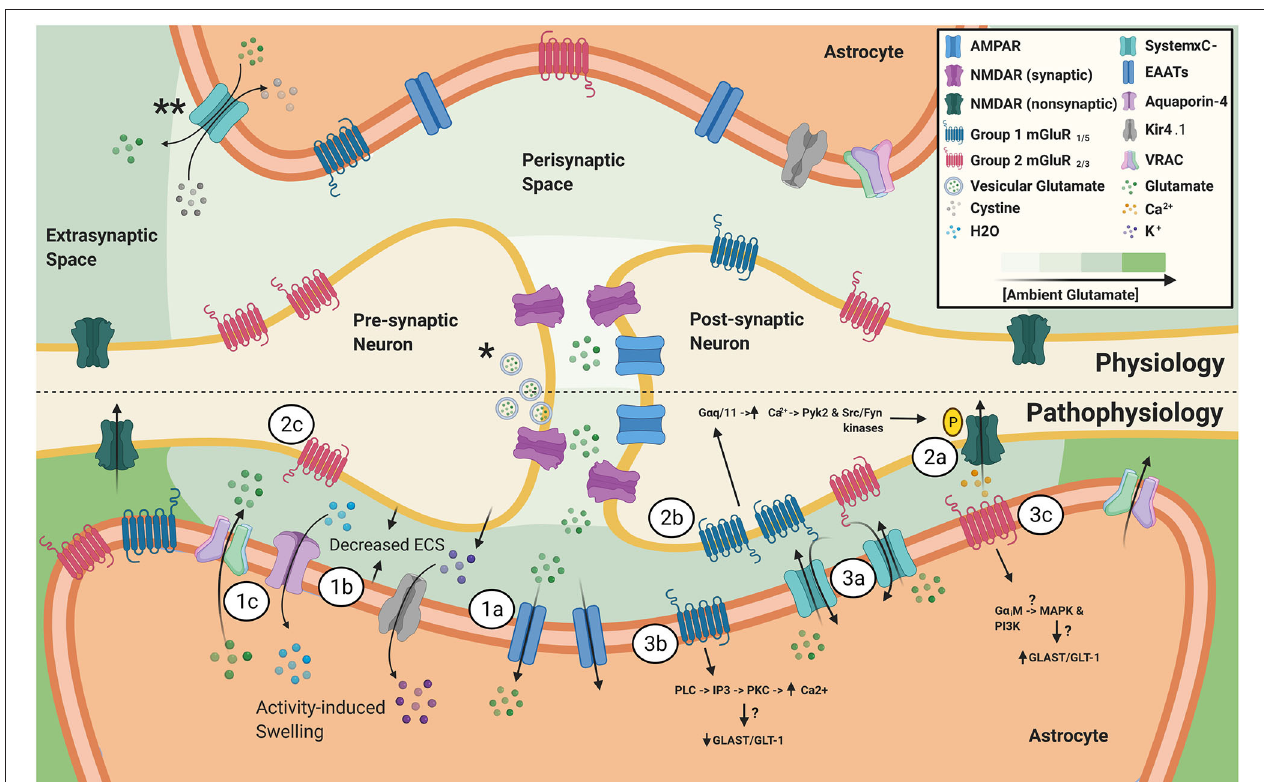
FIGURE 1 | *Vesicular glutamate release during action potentials is the primary source of synaptic glutamate. **SXC, primarily expressed on astrocytes, is a major source of ambient, extrasynaptic glutamate. Ambient glutamate concentration around the synapse, after EAAT activity, follows a gradient with the lowest level in the synaptic cleft to the highest in the extrasynaptic compartment. (1) Astrocyte homeostatic responses to increased activity from hyperexcitable neurons. (1a) Increased vesicular glutamate release from hyperexcitable neurons leads to increased astrocytic EAAT activity. (1b) Elevated neuronal activity also causes release of K + , in attempts to maintain homeostatic neuronal resting membrane potential. Next, astrocytic buffering of extracellular K + through elevated Kir4.1 activity, which is accompanied by increased H20 uptake through aquaporin-4, ultimately results in activity-induced astrocytic swelling and reduction in ECS. (1c) Astrocytic swelling leads to activation of VRAC and release of glutamate and other gliotransmitters into the ECS. (2) Pathophysiological effects of increased activity and changes in expression of neuronal extrasynaptic glutamate receptors. (2a) Activation of N2B-containing NMDARs leads to the generation of slow, depolarizing currents. (2b) Elevated expression and activity of group 1 mGluRs in epilepsy has been linked to increased NMDAR-mediated currents via a mechanism involving Ca 2 + -calmodulin dependent tyrosine phosphorylation of NMDAR subunits NR2A/B. (2c) Presynaptic group 2 mGluRs have been shown to inhibit glutamate and GABA release. Tissue from epileptic patients and animal models have revealed decreased mGluR 2 / 3 expression, which can contribute to a pro-epileptic brain state. (3) Changes in astrocytic glutamatergic protein expression in epilepsy. (3a) SXC expression has been found to be elevated in human epileptic tissue, as well as various epilepsy animal models. SXC activity leads to the release of glutamate from astrocytes. (3b) Animal models of epilepsy have revealed that persistent upregulation of astrocytic mGluR 5 was a reliable indicator of epileptogenesis. mGluR 5 activation leads to altered GLAST/GLT-1 expression and induces NR2B-dependent NMDAR mediated neuronal currents. (3c) Upregulation of mGluR 3 has been reported in epilepsy animal models and experimental activation of group 2 mGluRs in cultured astrocytes was shown to upregulate GLAST/GLT-1 expression, suggesting that a balance of group 1 and group 2 mGluRs on astrocytes is important in maintaining homeostatic extracellular